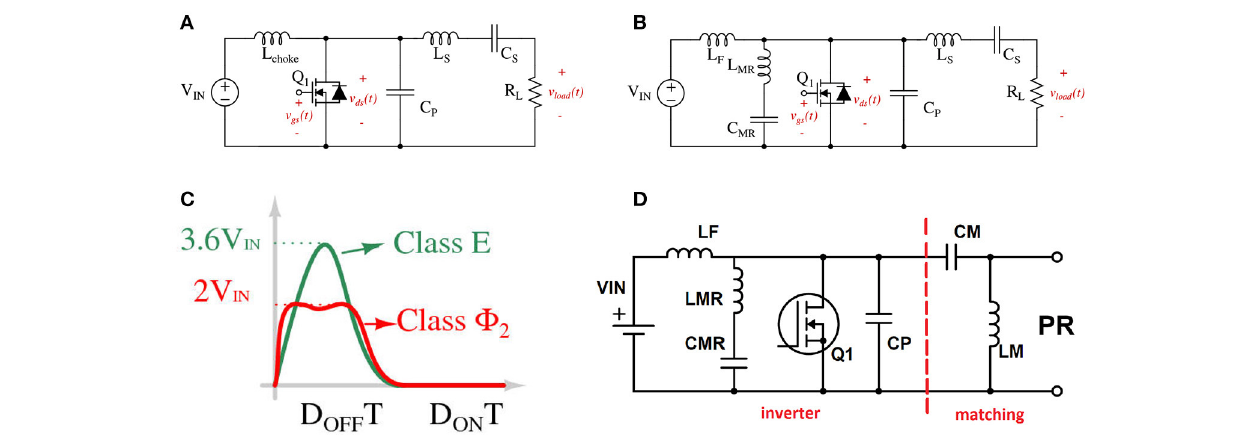
FIGURE 1 | Class 8 2 inverter has 40% reduction on semiconductor voltage stress and all of the inductors are part of the resonant network and can be implemented without magnetic core. (A) Class E inverter, first investigated in 1964 by Gerald Ewing [ 19], has been widely used in telecommunication applications. (B) Class 8 2 inverter. (C) Drain Voltage Comparison. (D) Class 8 2 with a high pass L matching network to drive an electro-thermal plasma micro-thruster (Pocket Rocket PR type [20]) for CubeSat